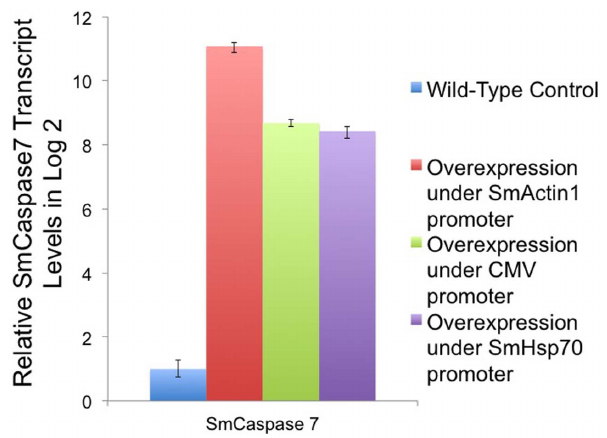
Figure 7. qRT-PCR quantitation of SmCaspase7 transcript in schistosomula expressing plasmid-based SmCaspase7 gene regulated by different promoters. SmCaspase7 was cloned into plasmids and its expression was controlled by the SmActin, CMV, or SmHsp70 promoter. Non-transfected, wild-type schistosomula were used as a negative control. Transcript levels were assessed by